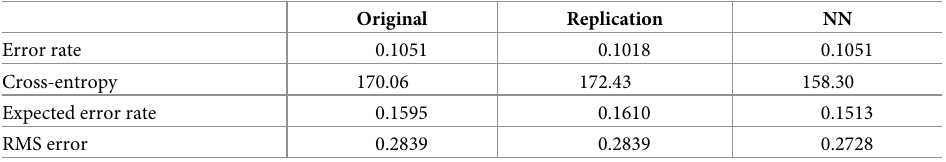
Table 3. Comparison of modelling approaches using four different measures of accuracy. The “Original” model is that of [27], the “Replication” is our attempt to replicate their model with available data for predictors, and “NN” is our neural network model as described in this paper, but using their predictors. The models are compared with the dataset described in their paper [27] and from VectorBase [54, 70,